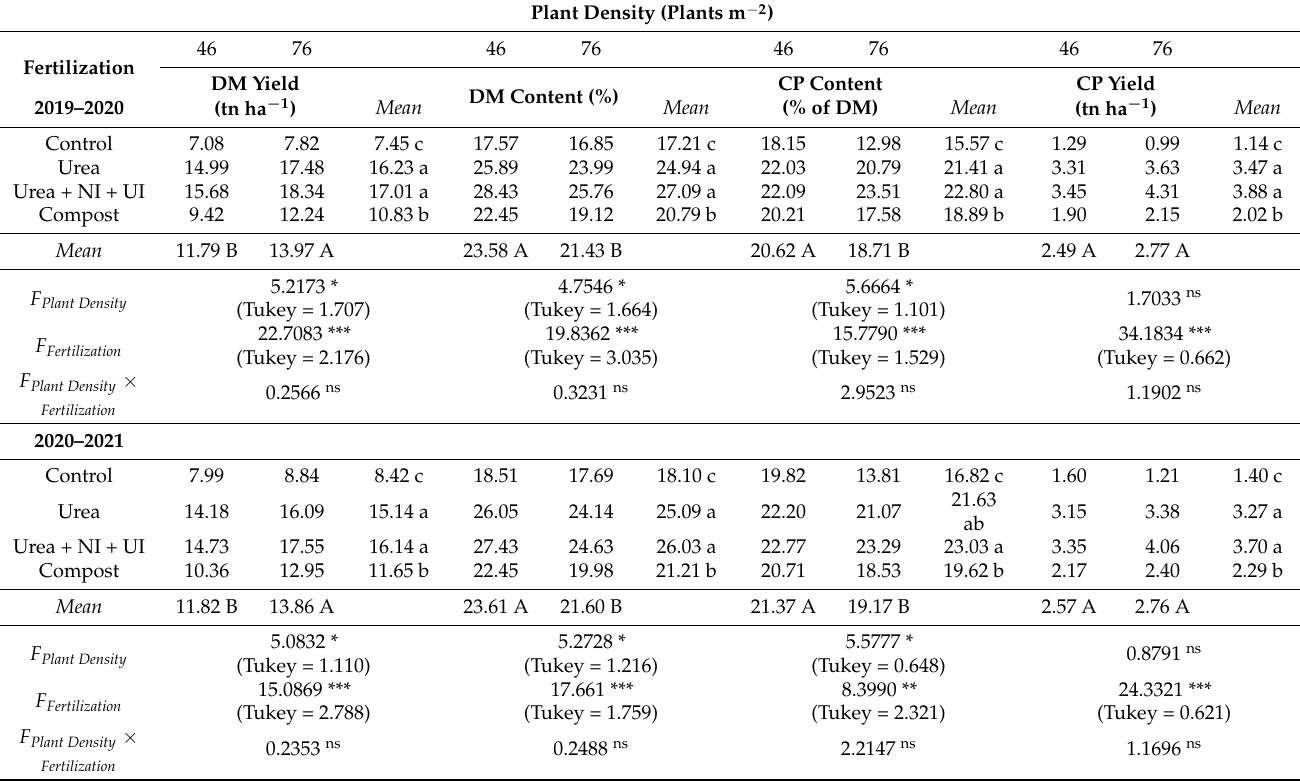
Table 2. Dry matter (DM) yield, DM content, crude protein (CP) content, and CP yield as influenced by the plant density and